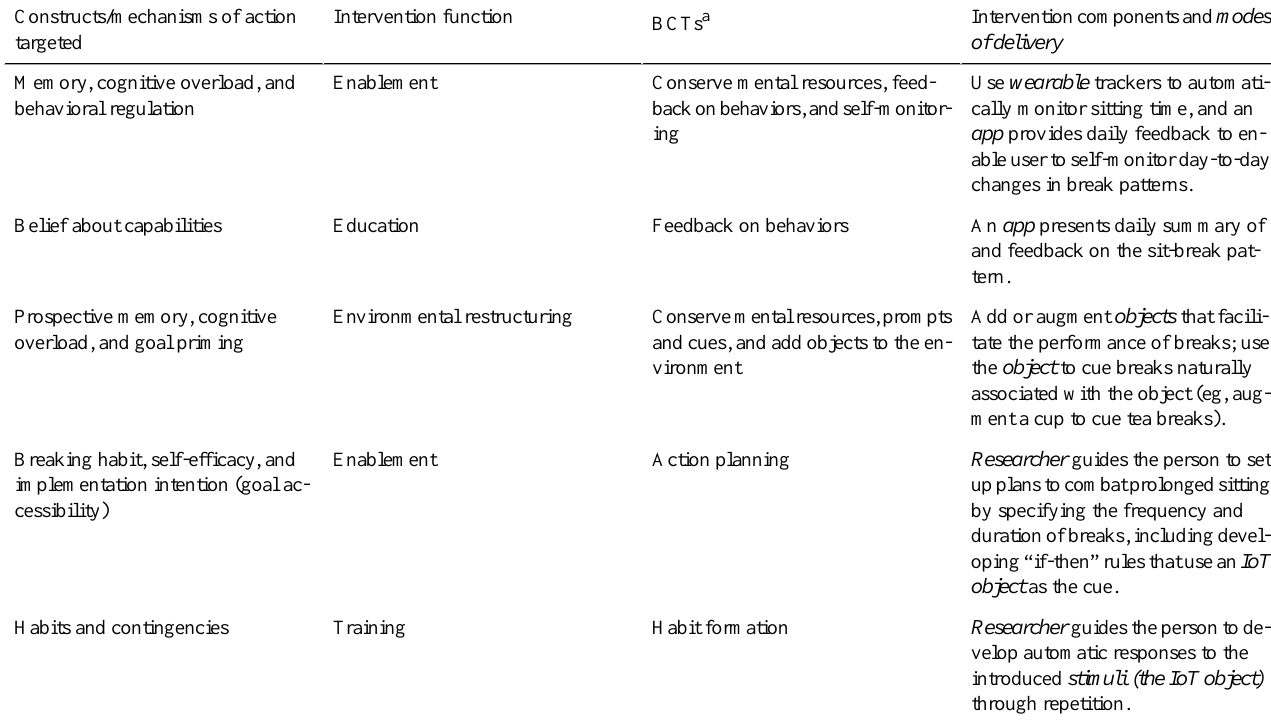
Table 1. Examples of intervention mapping following the behavior change wheel.